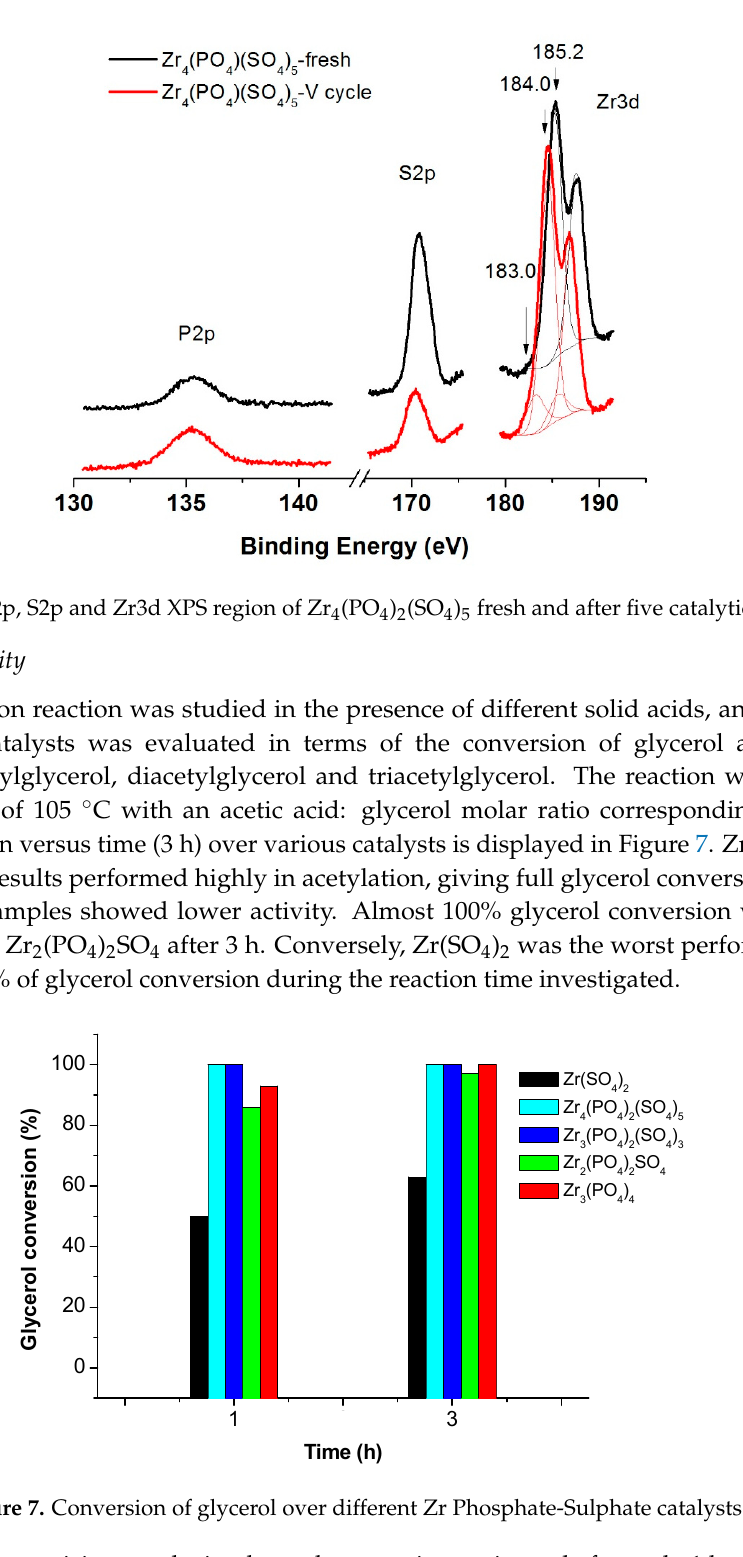
Figure 5. Zr3d XPS region for pure and mixed catalysts.